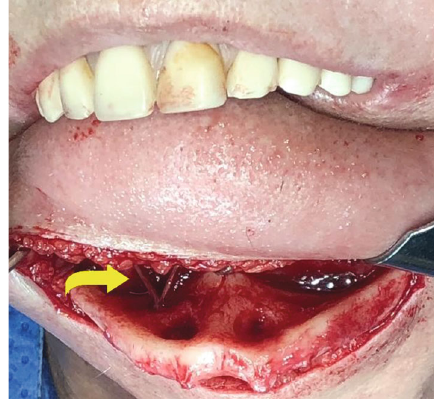
Figure 2: Mandible with severe bone resorption and exposure of the inferior alveolar nerve (yellow arrow).